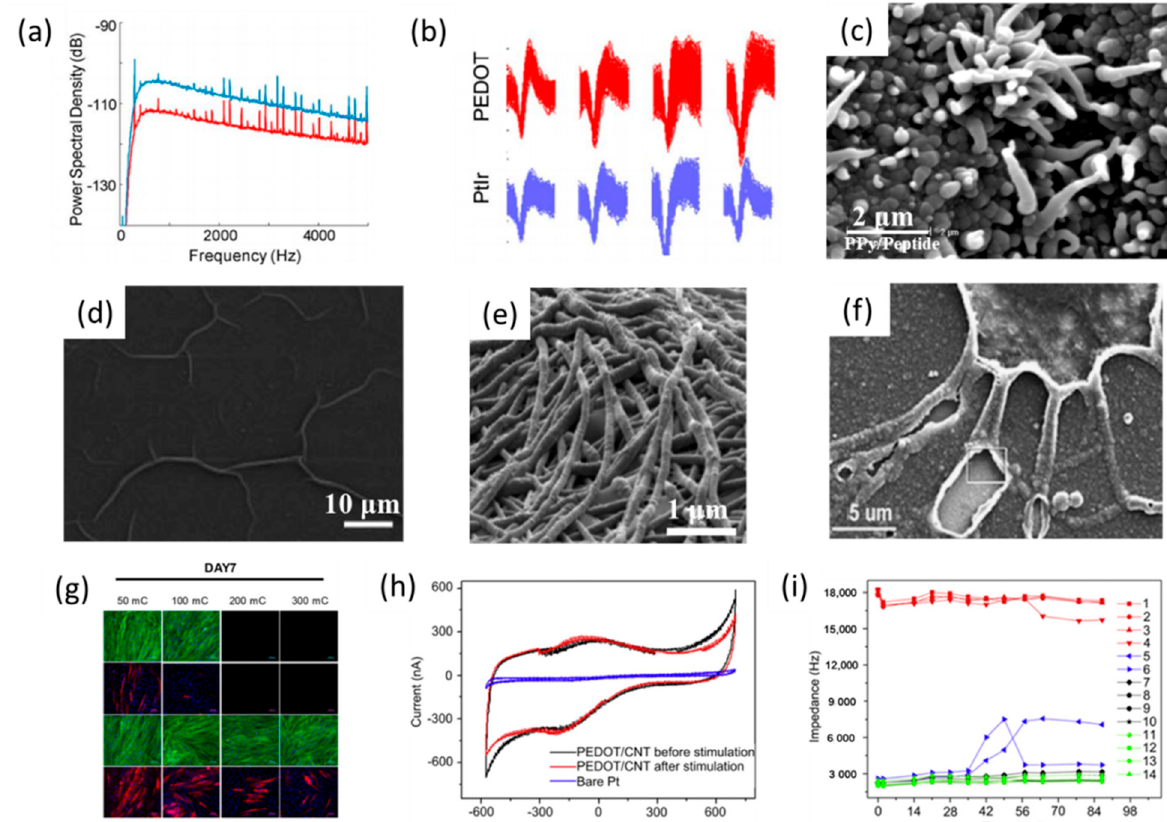
Figure 6. ( a ) Average power spectral density measured on the PEDOT and PtIr electrodes during surgery under high isoflurane. ( b ) 100 overlaid action potential waveforms (0.8 ms for each) recorded on different electrodes of the same ar-